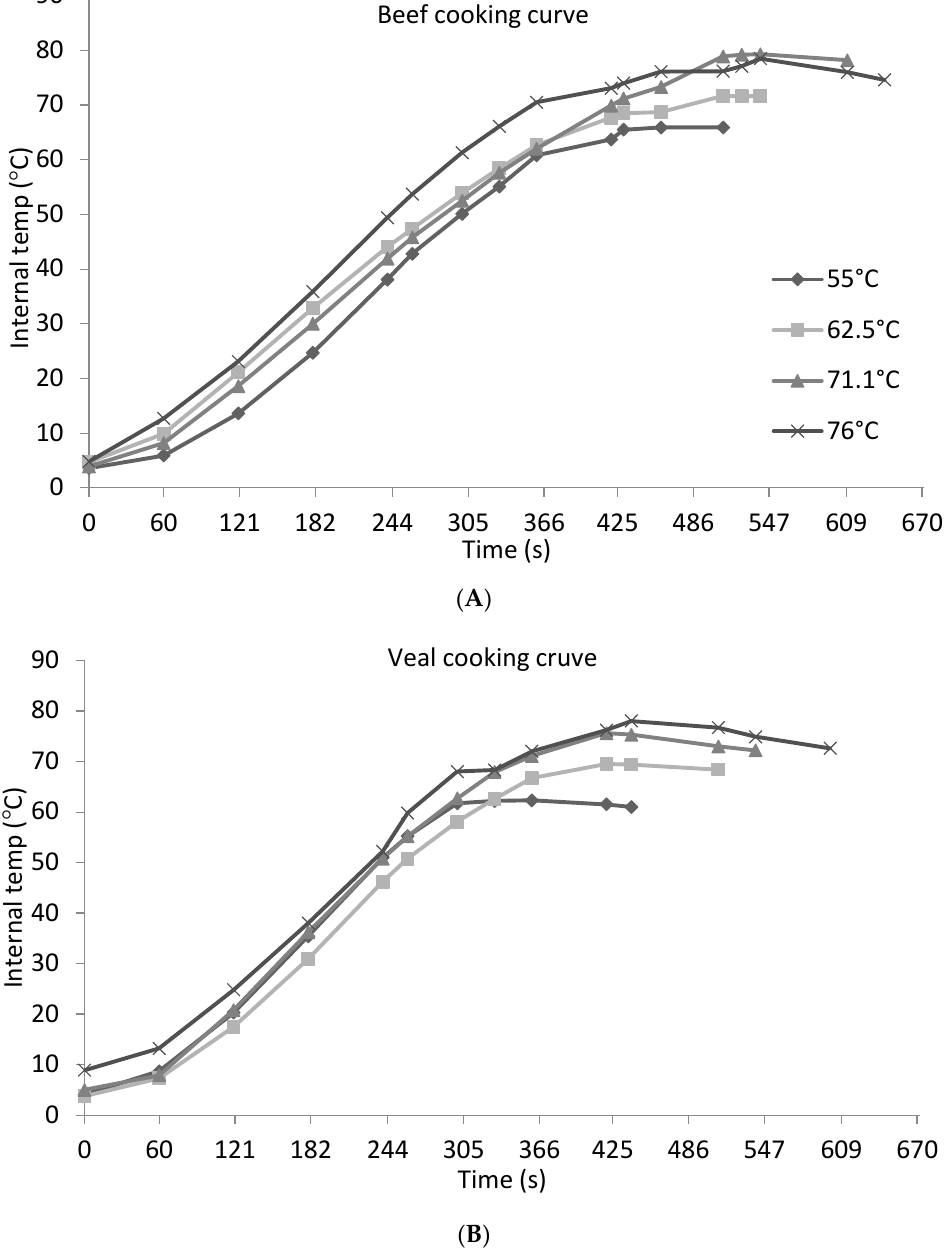
Figure 1. Cooking times and temperature curves for non-intact course ground beef ( A ) and veal ( B ) patties that were cooked by double pan-broiling using a Farberware grill.